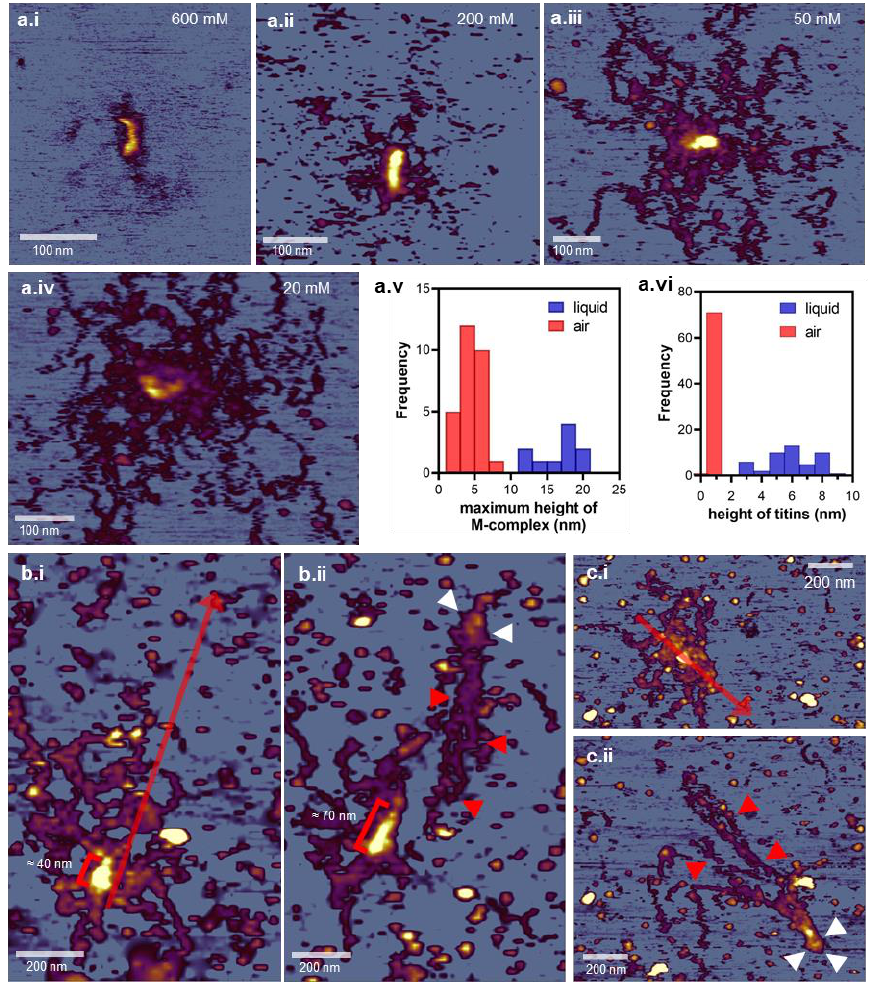
Figure 7. Nanosurgical manipulation of the M-complex in aqueous buffer solution. ( a ) Effect of ionic strength on the adsorption of the titin oligomer to mica. ( a.i – a.iv ) AFM images of titin oligomers at progressively decreasing ionic strengths. The ionic strength was adjusted with KCl, the concentration of which is indicated in the upper right corner of the images. ( a.v ) Comparison of the maximum topographical height of the M-complex in air (red) and aqueous buffer (blue). ( a.vi ) Comparison of the maximum topographical height of titin molecules in air (red) and aqueous buffer (blue). ( b.i ) Control AFM image of a titin oligomer before nanosurgical manipulation in buffer. Red arrow indicates the site, direction and distance of the manipulation. The red bracket marks the M-complex. ( b.ii ) AFM image recorded after nanosurgical manipulation. Besides extension (from 40 to 70 nm), large parts of the titin oligomer were dislodged and displaced. Red and white arrowheads mark displaced titin strands and parts of the M-complex, respectively. ( c.i ) Control AFM image of a titin oligomer before nanosurgical manipulation in buffer. Red arrow indicates the site, direction, and distance of the manipulation. ( c.ii ) AFM image recorded after nanosurgical manipulation. The entire titin oligomer was displaced with a net distance of 750 nm. Red and white arrowheads mark displaced titin strands and parts of the M-complex,